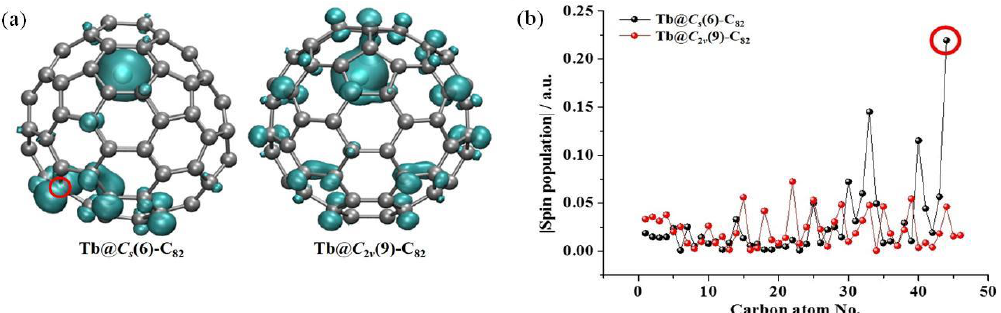
Figure 7. ( a ) Visualized spin density distributions and ( b ) corresponding spin population values of unequivalent cage carbon atoms of Tb@C S (6)-C 82 and Tb@C 2v (9)-C 82 . The absolute values are